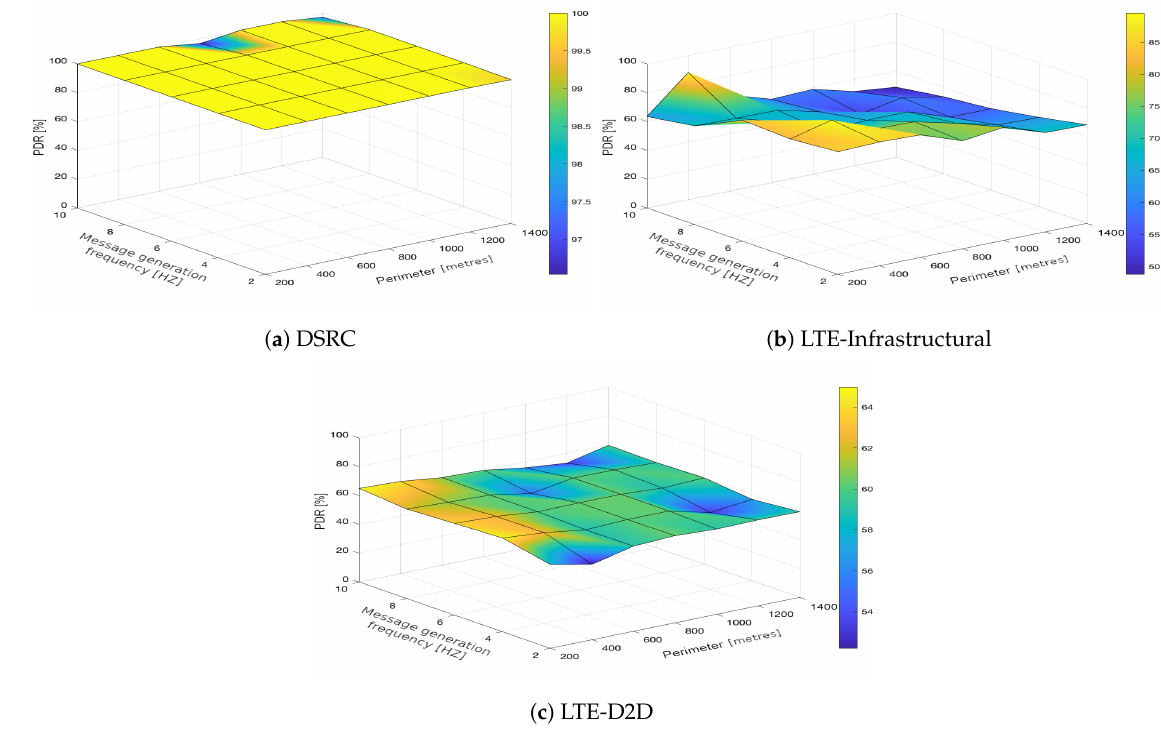
Figure 7. Packet delivery ratio obtained for the traffic intensity of 1500 vehicles per